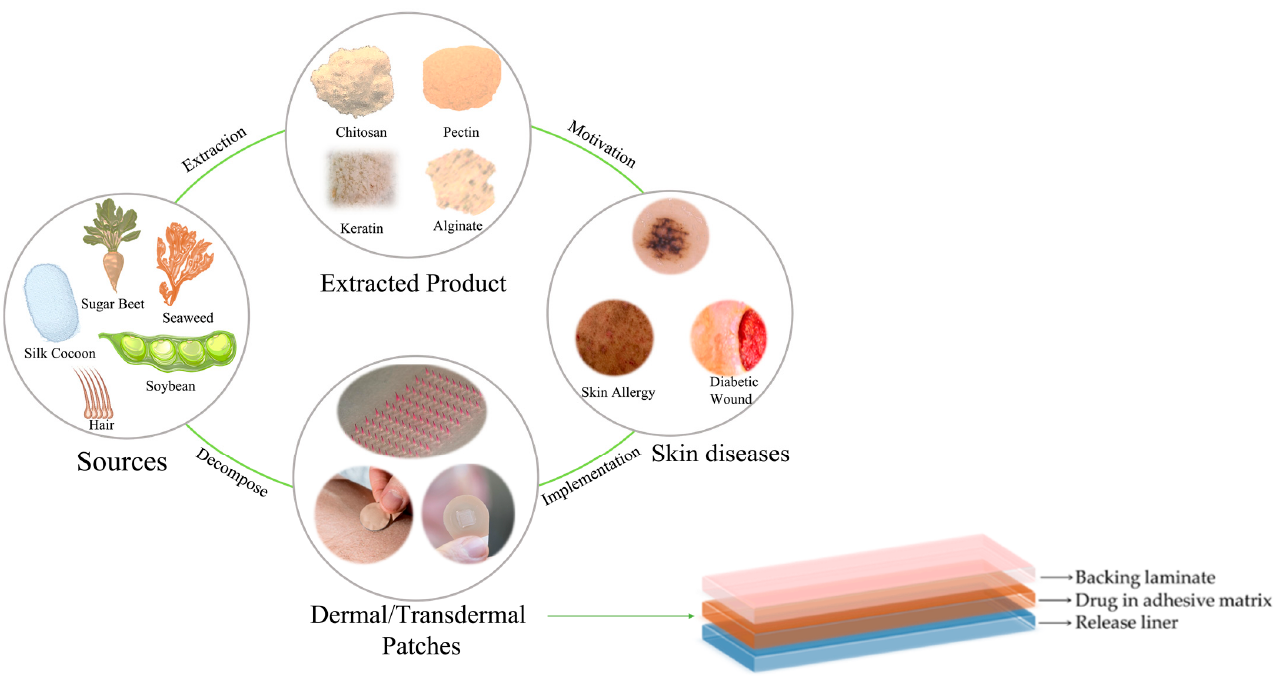
Figure 2. Dermal/transdermal patches are produced to treat different skin diseases using sustainable ecofriendly biopolymers derived from natural resources. Copyright permission for reuse from the refs. [33–37]. The image on the lower right corner illustrates the overall structure of a patch containing backing laminate, drug-loaded adhesive matrix, and release liner.